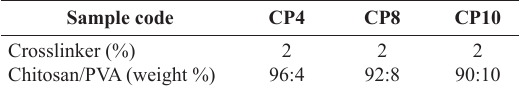
Table 1. Composition and codes of CS/PVA blends.